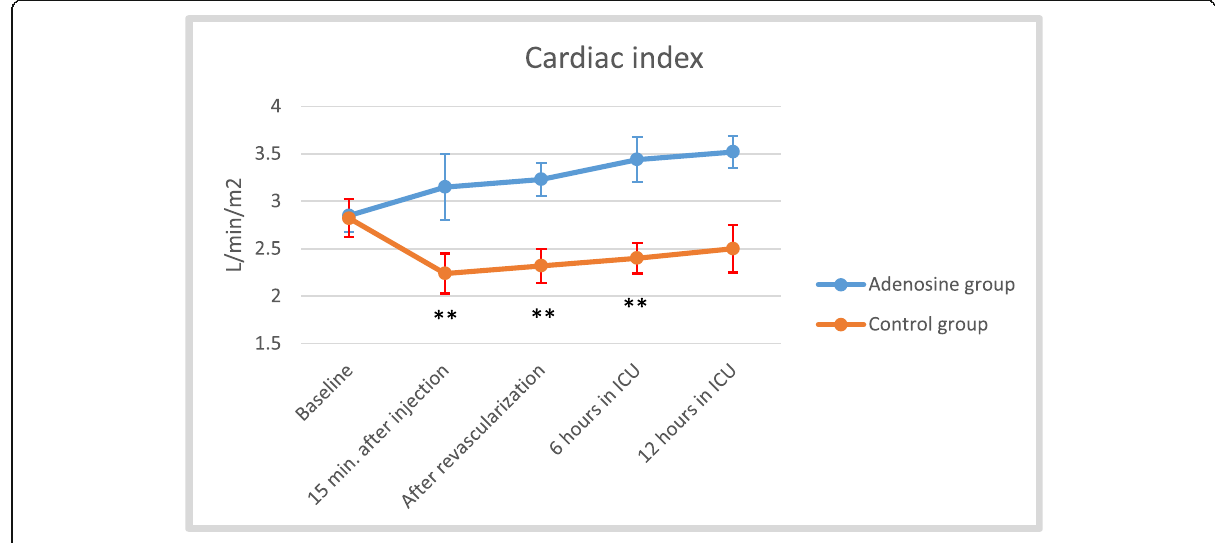
Fig. 6 Effect of adenosine on cardiac index (CI). Data were presented as mean ± SD. ** P value highly significant